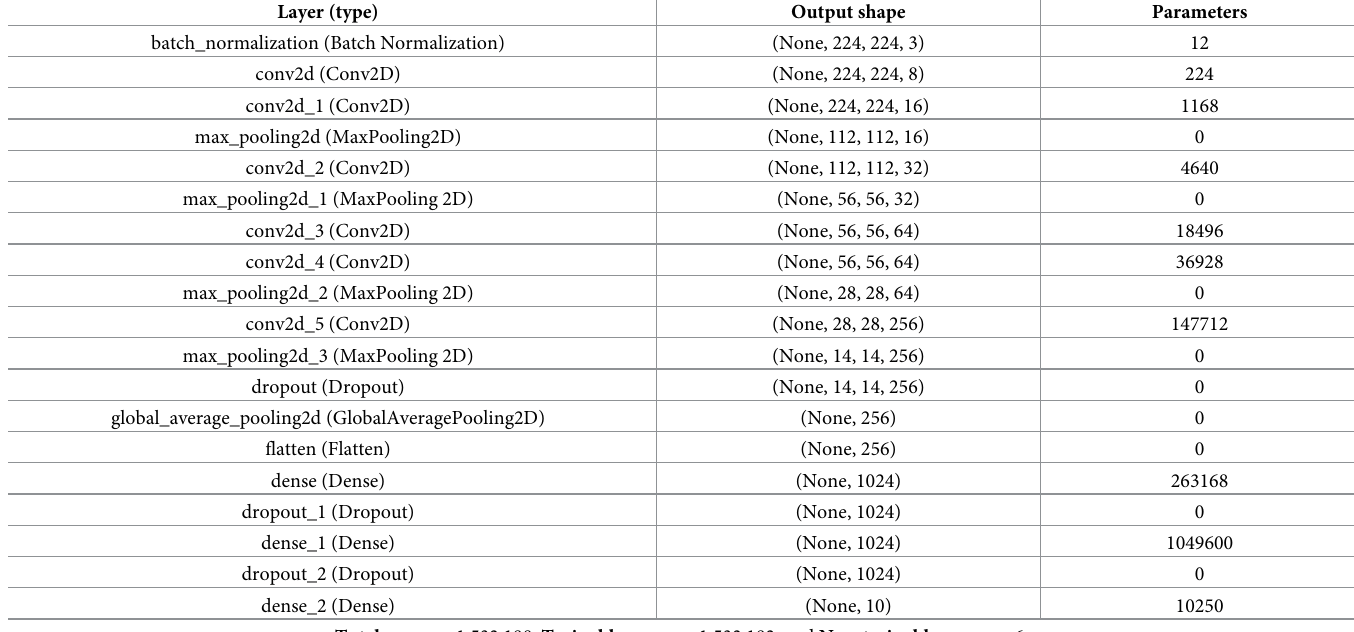
Table 2. Specifications of the CNN layers in the proposed scratch algorithm.